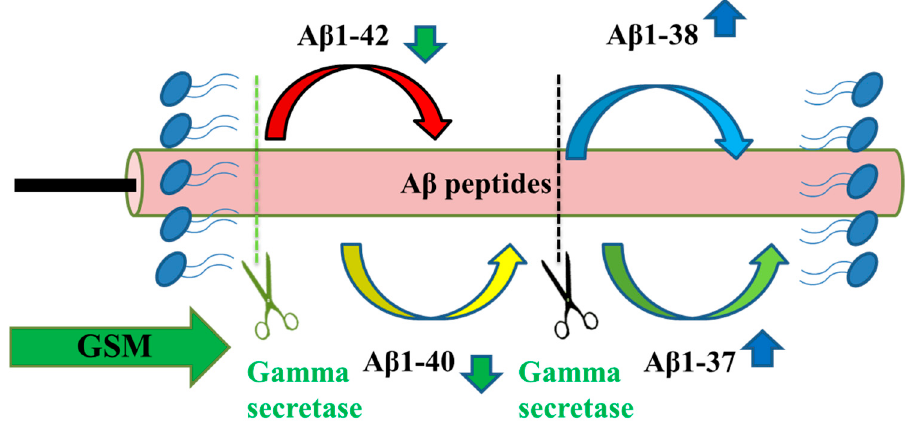
Figure 5. γ -secretase modulators. GSMs do not inhibit γ -secretase, but they can shift the profile of the secreted beta-amyloid peptides produced. GSMs can decrease the levels of A β 1–42 peptides and increase the levels of A β 1–38 peptides. A β = beta-amyloid and GSM = γ -secretase modulators.